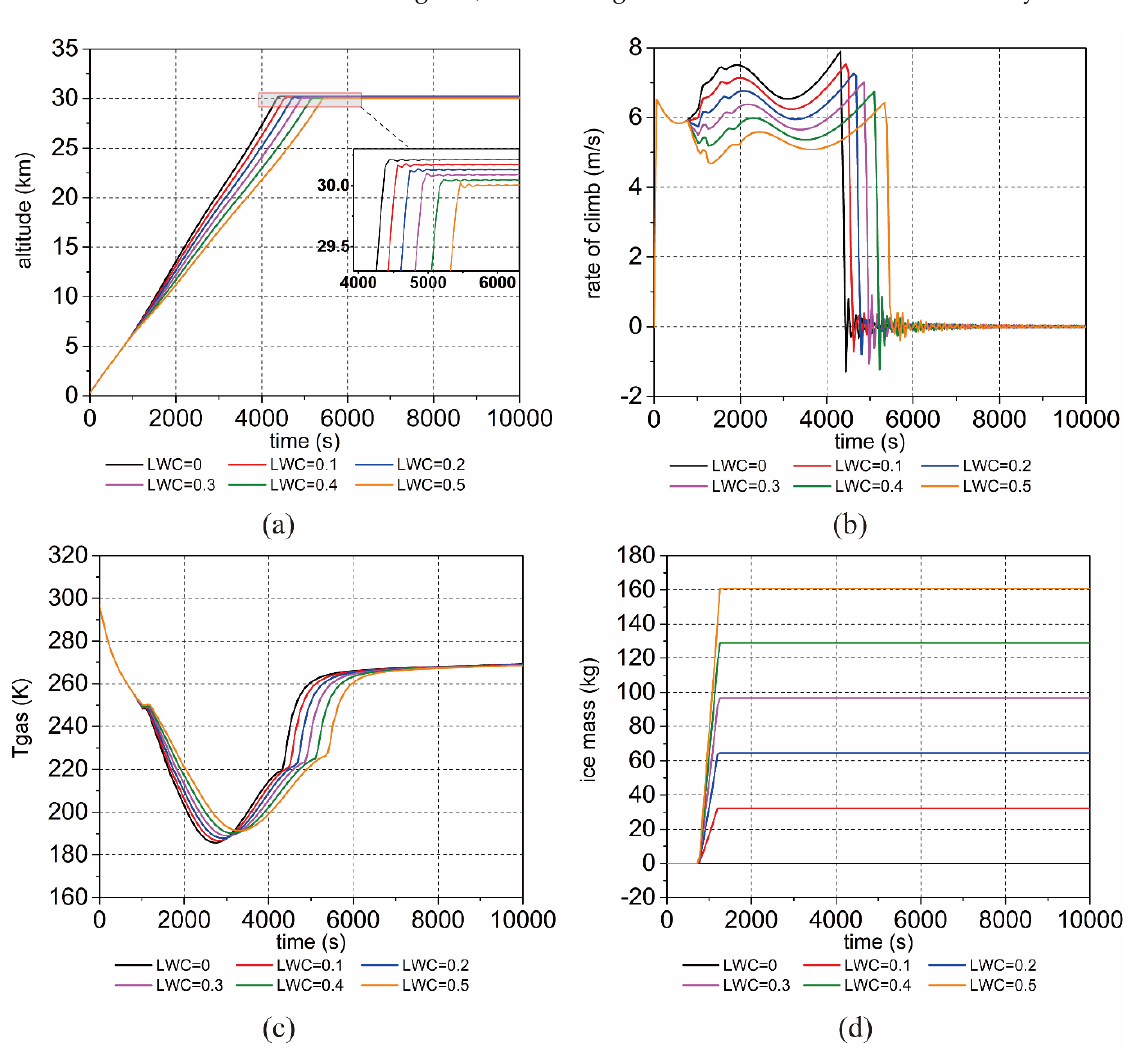
Figure 8. Ascent performance of ( a ) altitude, ( b ) velocity, ( c ) helium temperature, and ( d ) ice mass at different LWCs.